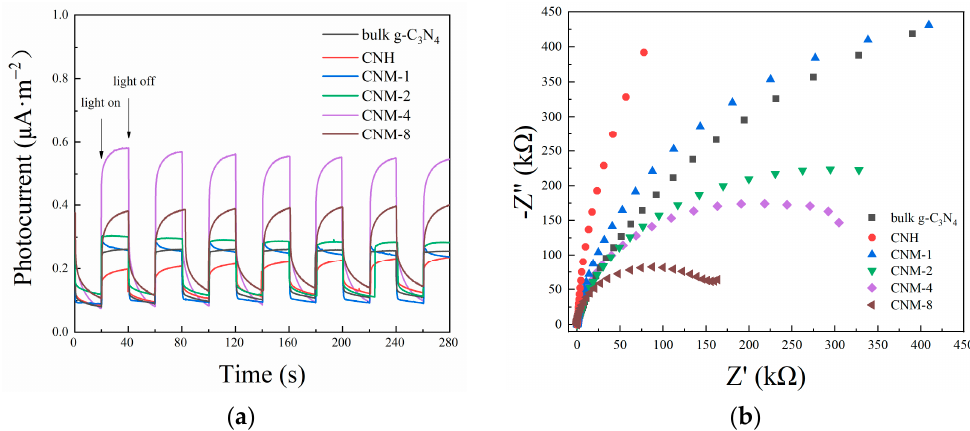
Figure 8. Photoelectrochemical results of bulk g-C 3 N 4 , CNH, and all the exfoliated g-C 3 N 4 /MoO 2 composites: ( a ) transient photocurrent response curves and ( b ) EIS Nyquist plots.